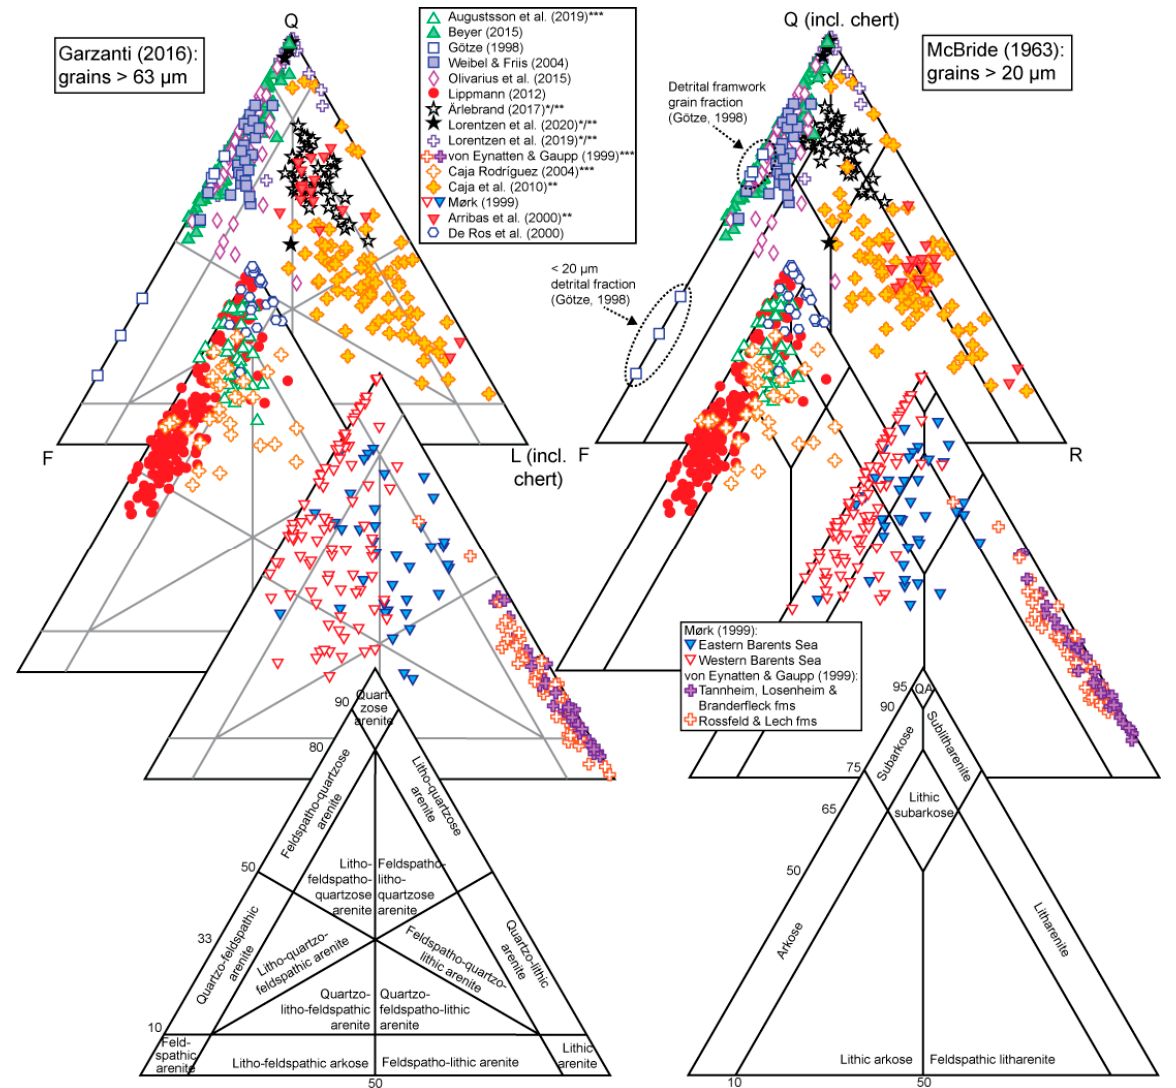
Figure 2. Sandstone classification of the rocks in the used data set based on the scheme of Garzanti [23] ( left ) and McBride [56] ( right ). All data are plotted, also the few samples that formally would be other rock types than sandstone. The grain-matrix cut-off for the sandstone of Götze [32] (for which the composition for the <20 µm fraction also is provided) is unknown. * Point-counting with a matrix limit of 20 or 30 µm; ** Gazzi–Dickinson point counting; *** Modified Gazzi–Dickinson (all rock fragments assigned to L) or Indiana point counting. The used counting methods for the other studies are unspecified. F: feldspar; L: lithic fragments (as defined by the Gazzi–Dickinson method, and including carbonate grains); Q: quartz (both monocrystalline and polycrystalline grains); QA: quartzarenite; R: rock fragments (including carbonate grains).